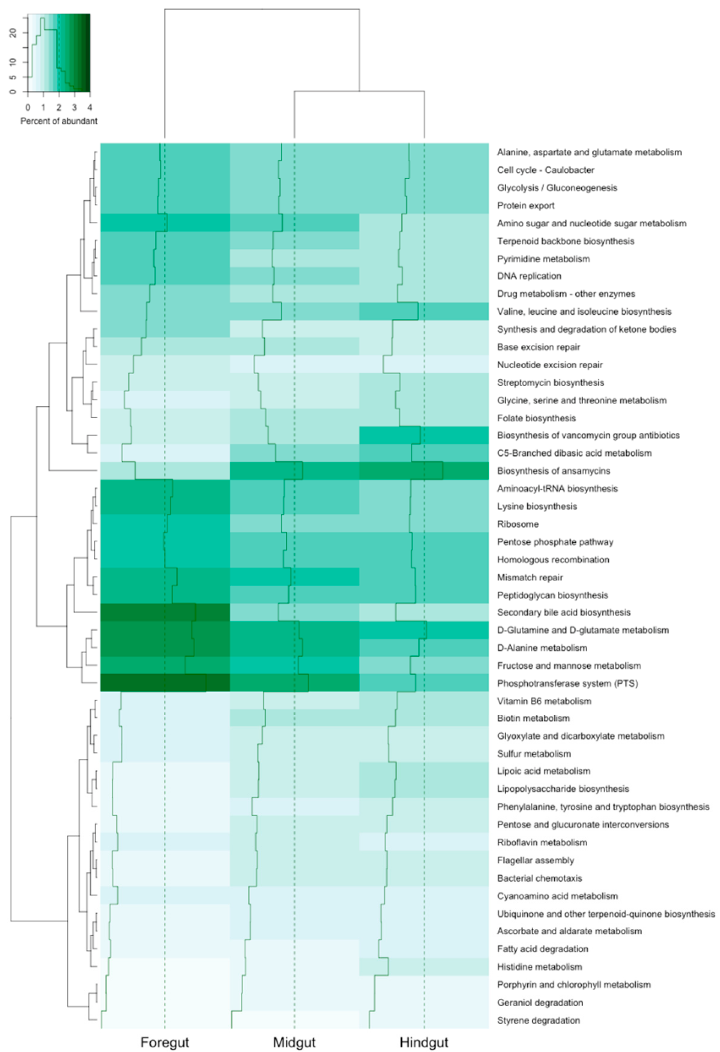
Figure 7. Hierarchical clustering graphics of the gene functions distance of bacterial communities (left) among foregut, midgut and hindgut (top) of Xylocopa tenuiscapa intestinal tracts by cluster analysis. The percent of functional gene abundance is shown on the top left with distribution of counts ( y -axis). List of functional genes is shown on the right.